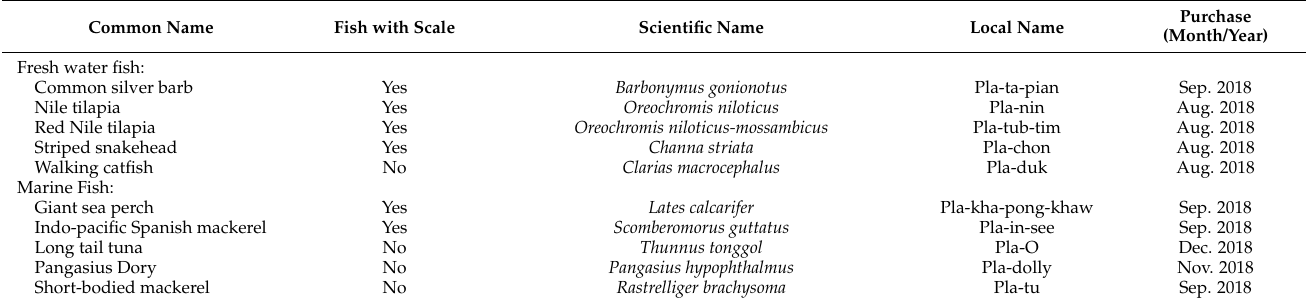
Table 1. The selected top 10 most-commonly consumed fish used in this study.